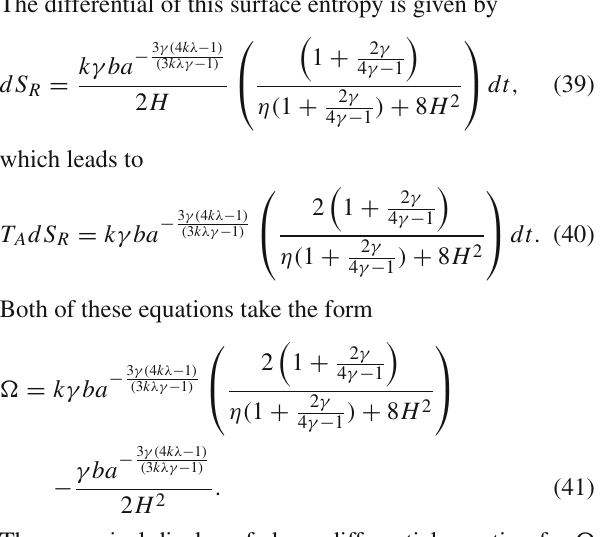
´ S T against scale factor a for Figure 11 indicates the plot of three values of γ . The trajectories in the plot are remain pos- ´ S T ≥ 0 for all values of γ which itive and obey the condition give the validity of GSLT. The second order differential equa- tion takes the form